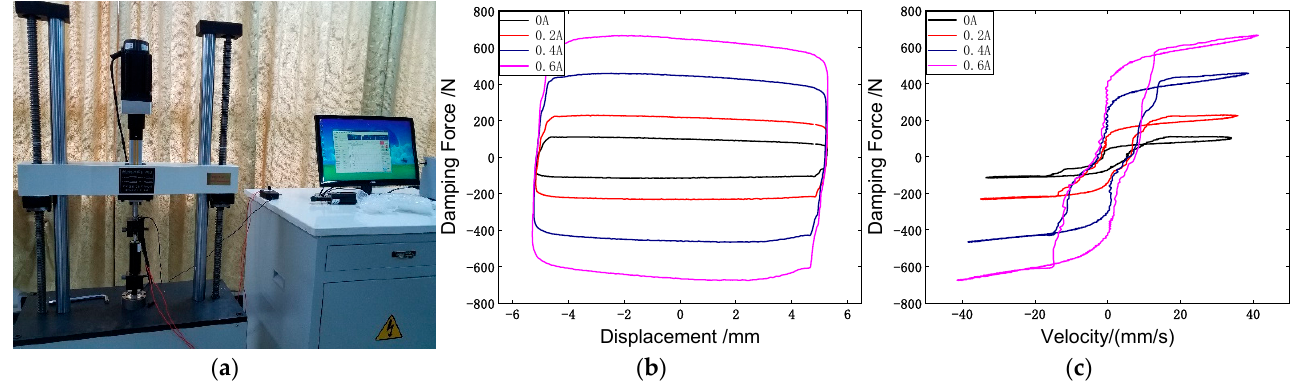
Figure 1. Experiment. ( a ) Test equipment; ( b ) Damping force versus displacement; and ( c ) Damping force–velocity.